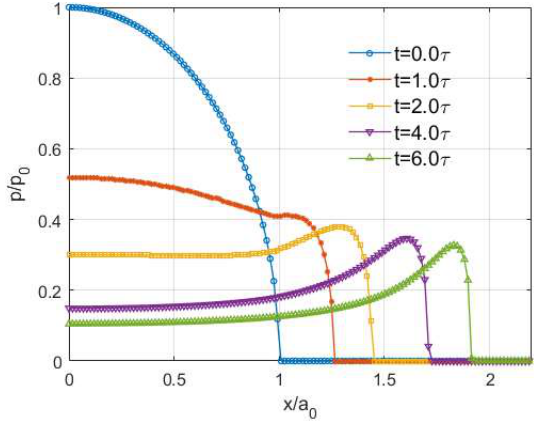
Figure 11. Distribution of normal pressure at different time points within the simulation window ( 𝑡 = 6.0𝜏) .